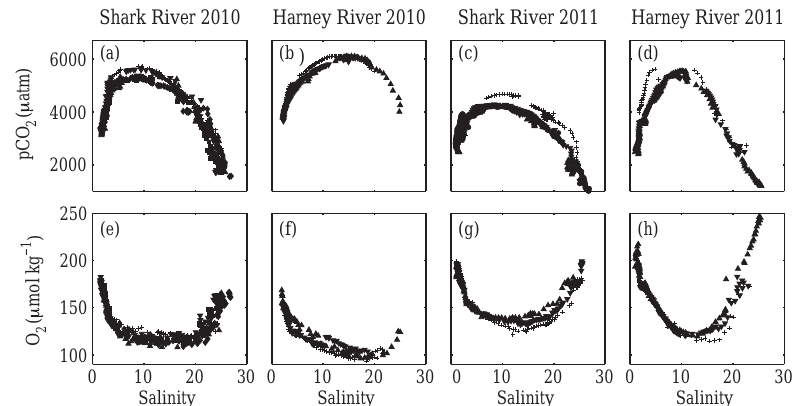
Figure 2. Distributions of p CO 2 (a–d) and dissolved O 2 (e–h) along the salinity gradient in the Shark and Harney rivers during the 2010 (SharkTREx 1) and 2011 (SharkTREx 2) campaigns. Different symbols represent measurements made on different days.